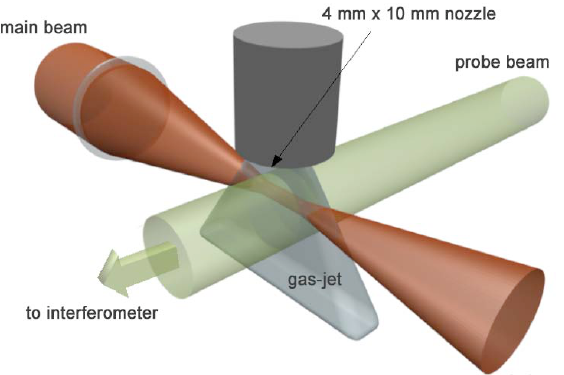
Figure 9. Schematic view of the target and interaction geometry, showing the gas-jet nozzle, the slab of gas, the main laser pulse and the probe pulse for plasma